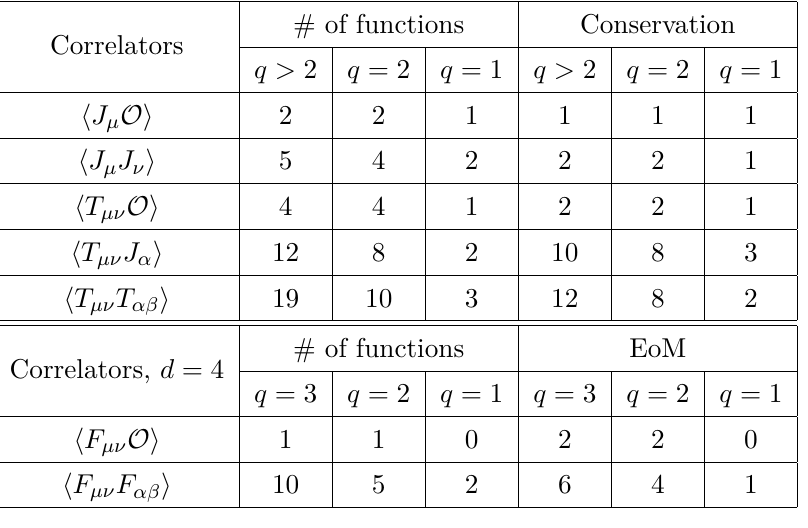
Table 2 . This table contains a list of bulk-bulk correlators which we consider in section 3 and the number of independent structures appearing in the correlators, dependent on the co-dimension q . It also denotes the number of PDE constraints arising from conservation of current ∂ µ J µ = 0 and stress tensor ∂ µ T µν = 0 , everywhere in the bulk. Correlators involving a Maxwell field strength F µν are also considered, specifically when d = 4 , and we list the number of PDE constraints arising from the bulk equation of motion ∂ µ F µν = 0